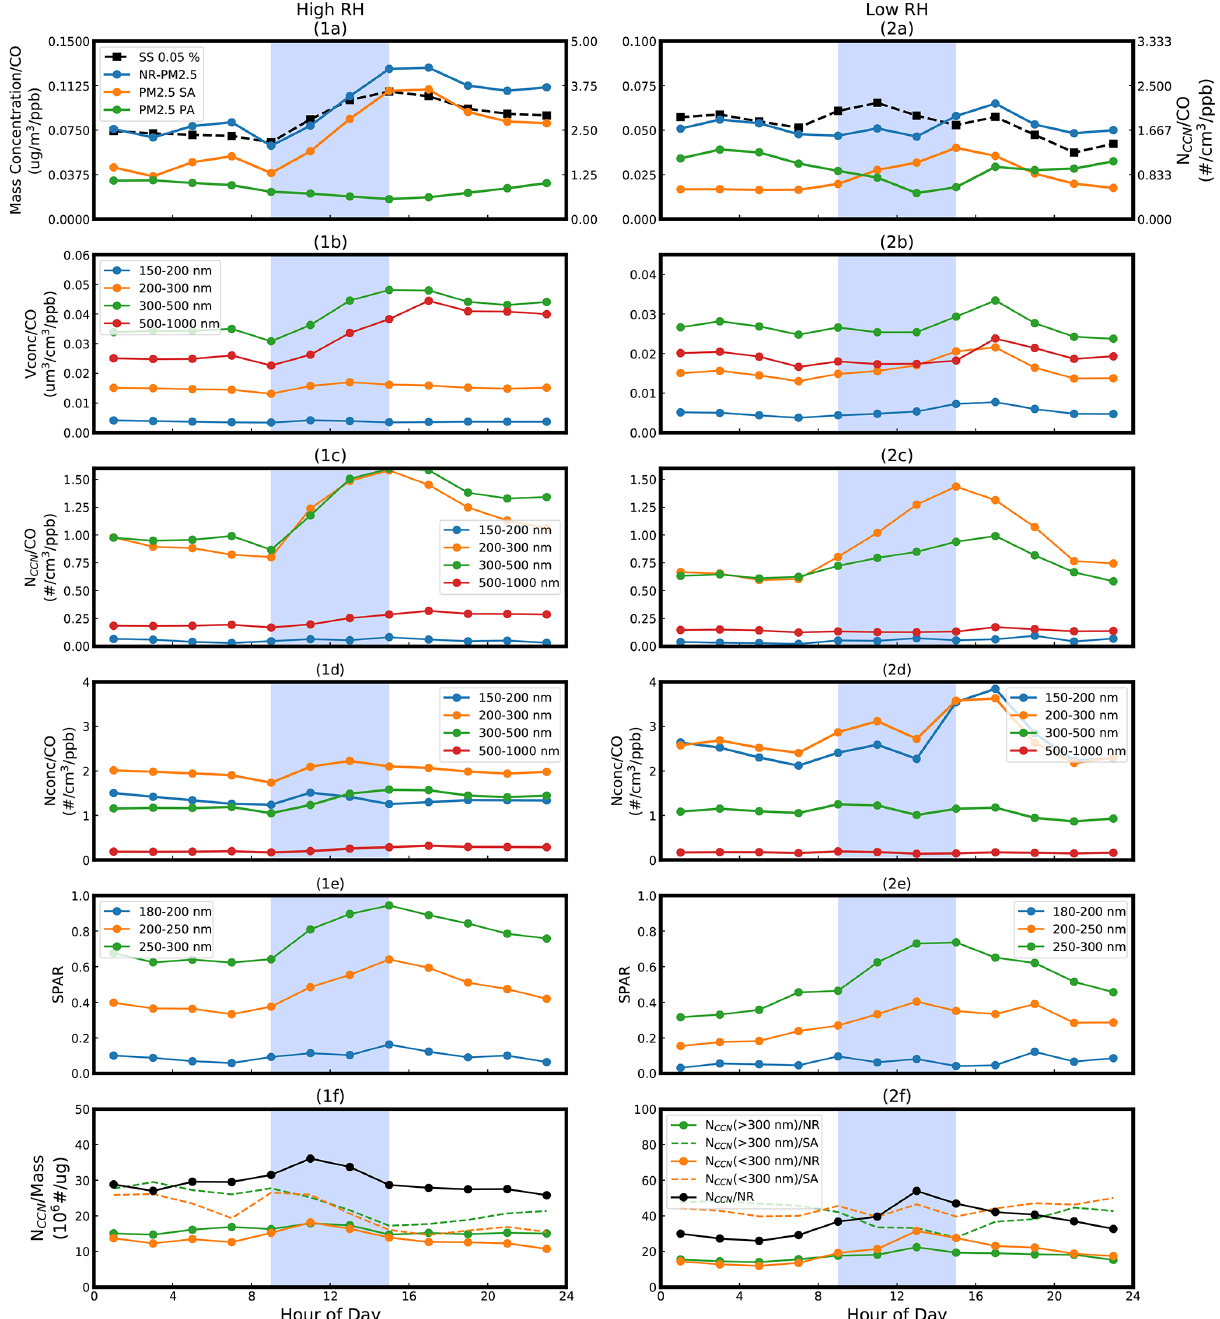
Figure 4. During different RH events, the average diurnal variation of (a) the ratios between particle mass concentration (dots with solid lines; blue: NR-PM 2 . 5 ; yellow: PM 2 . 5 SA; green: PM 2 . 5 PA) and CO concentration and the ratio between N CCN at SS of 0.05% and CO concentration (squares with solid line); (b) the ratios between particle volume concentration ( V conc ) of different particle size range (indicated by colors) and CO concentration; (c) the ratios between N CCN of different particle size range at SS of 0.05% (indicated by colors) and CO concentration; (d) the ratios between particle number concentration ( N conc ) of different particle size range (indicated by colors) and CO concentration; (e) SPAR of different particle size range (indicated by colors); (f) the ratios between N CCN at SS of 0.05% (black: bulk N CCN ; yellow: N CCN with particle size larger than 300nm; blue: N CCN with particle size smaller than 300nm) and mass concentration of NR-PM 2 . 5 SA and the ratios between N CCN and mass concentration of NR-PM 2 . 5 (dashed